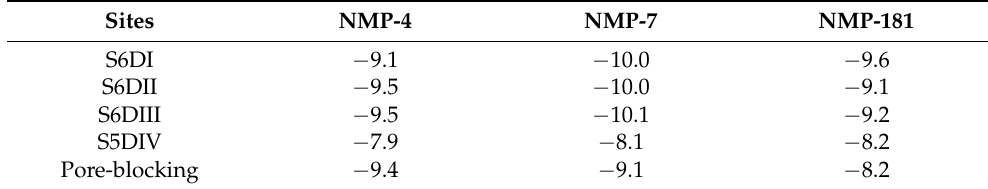
Table 3. ∆ G (kcal/mol) interaction energy of the anandamide conformers and NMP compounds with the Ca v 3.2